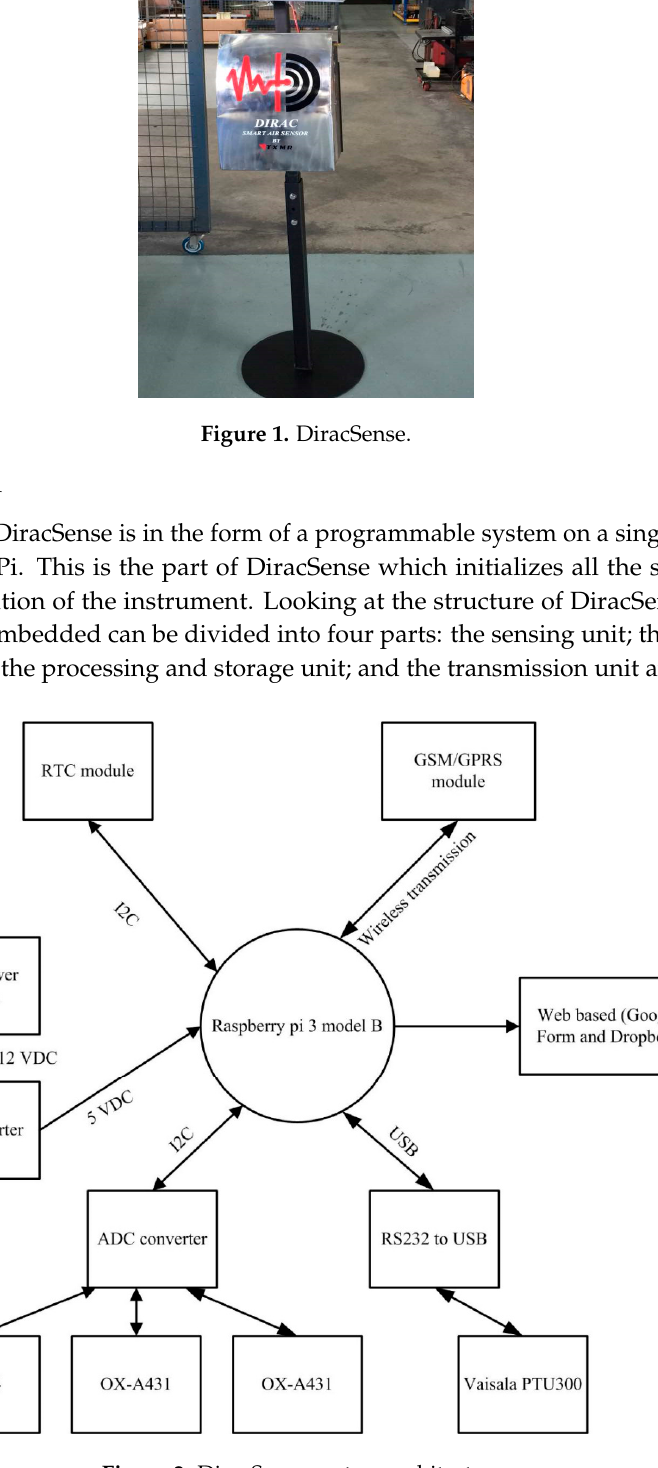
Figure 2. DiracSense system architecture.